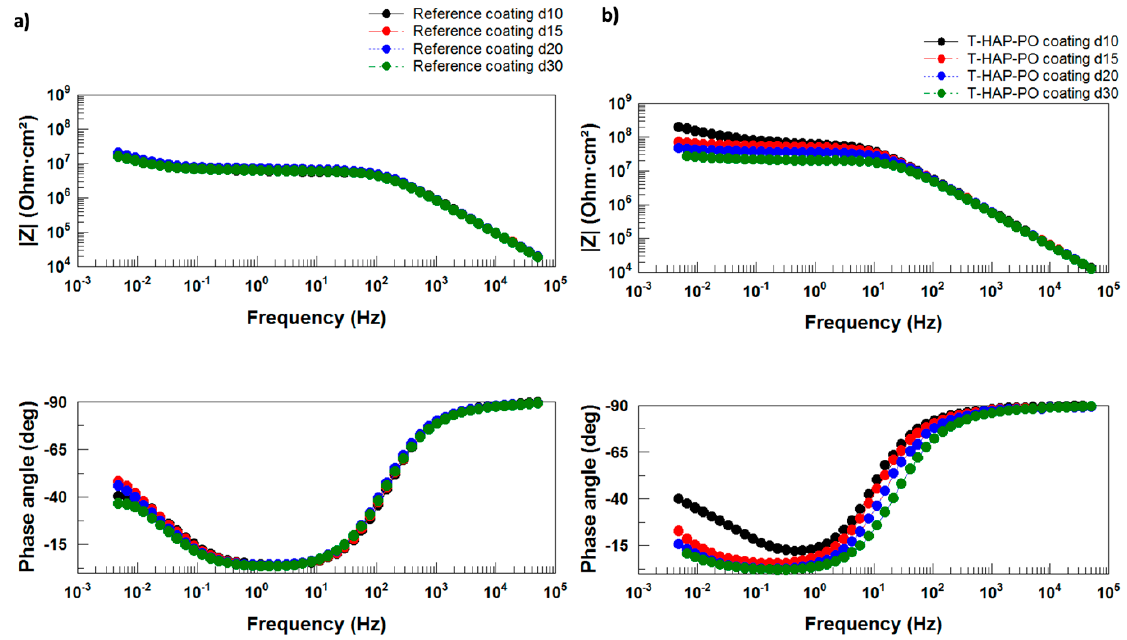
Figure 4. EIS Bode plots for the ( a ) reference coating and ( b ) coating modified with HAP particles loaded with tannic acid during immersion in 0.05 M NaCl.